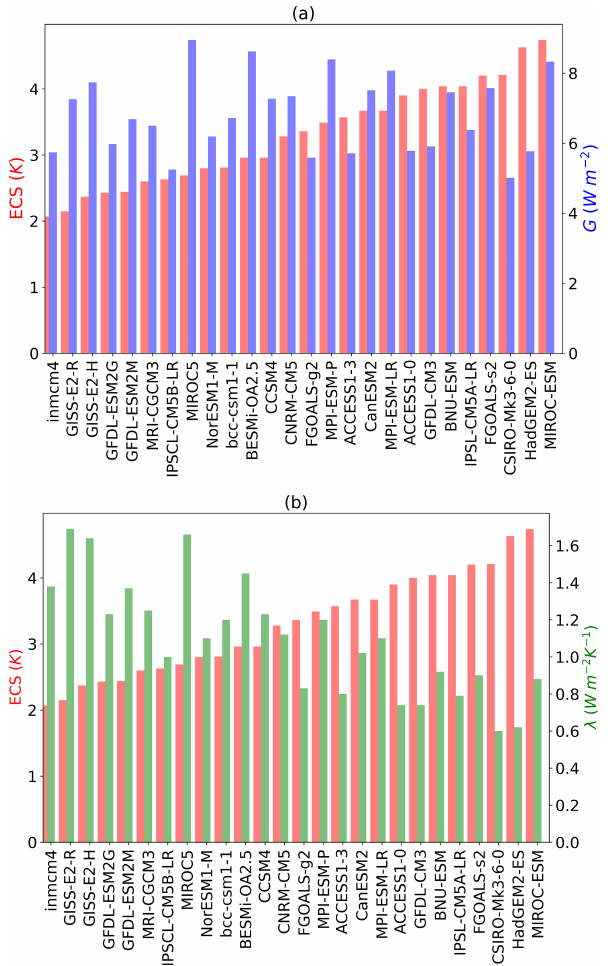
Figure 2. (a) Equilibrium climate sensitivity (ECS, in red) and ra- diative forcing ( G , in blue) values with ECS values increasing from left to right; (b) ECS (red) and climate sensitivity ( λ , in green) with ECS values increasing from left to right.